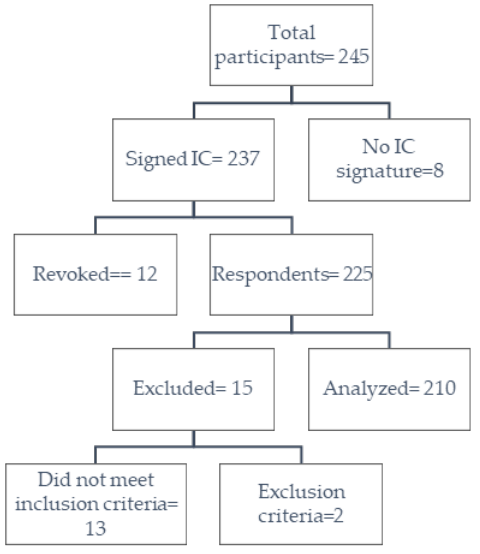
Figure 1. Summary of participants. IC: Informed consent.